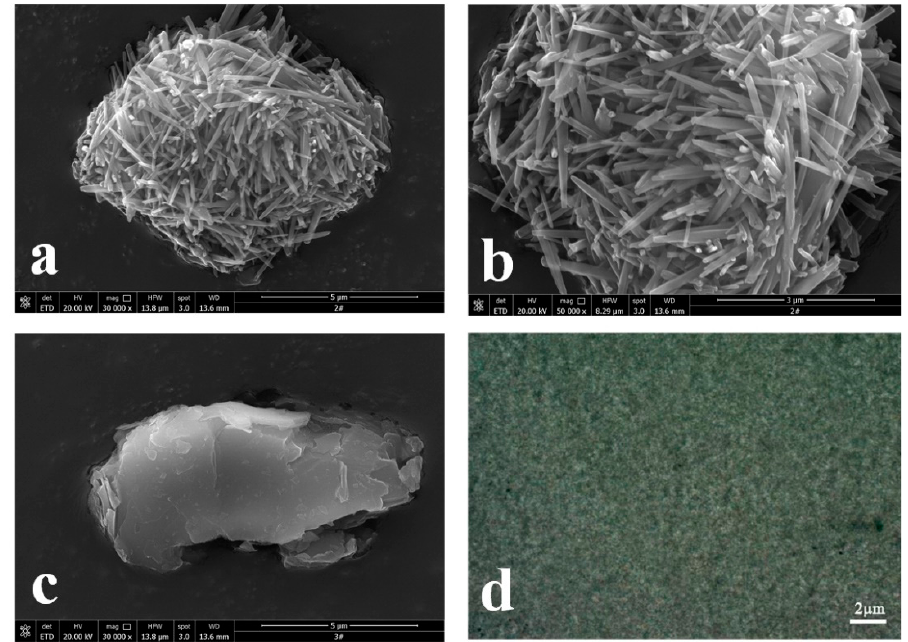
Figure 2. SEM ( a – c ) and microscope ( d ) images for halloysite ( a , b ) and illite ( c , d ).